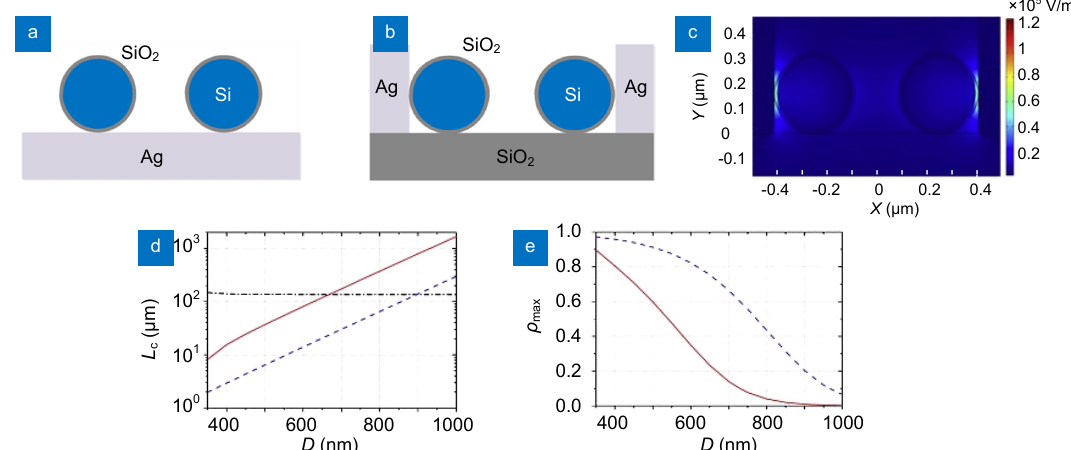
Fig. 4 | Schematic diagrams of ( a ) hybrid waveguide and ( b ) its rotation, ( c ) distribution of E y fi eld for rotation hybrid waveguide, ( d ) coupling length L c and ( e ) maximum power transfer P max as functions of the separation D , the red solid line and blue dotted line represent the results of the two structures of ( a ) and ( b ) , respectively 25 .